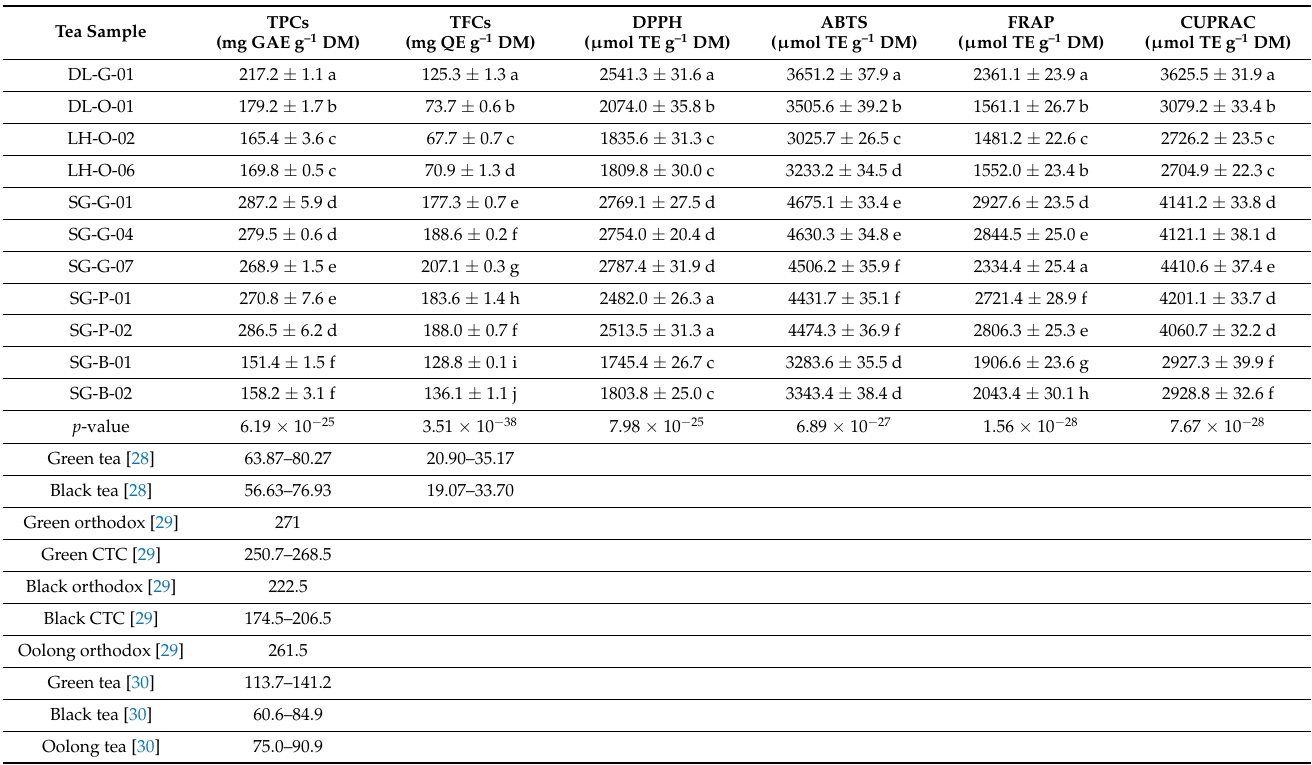
Table 1. The variation of TPCs, TFCs, and antioxidant activities (DPPH, ABTS, FRAP, CUPRAC) in dried tea products of different geographical origin and the different tea varieties in